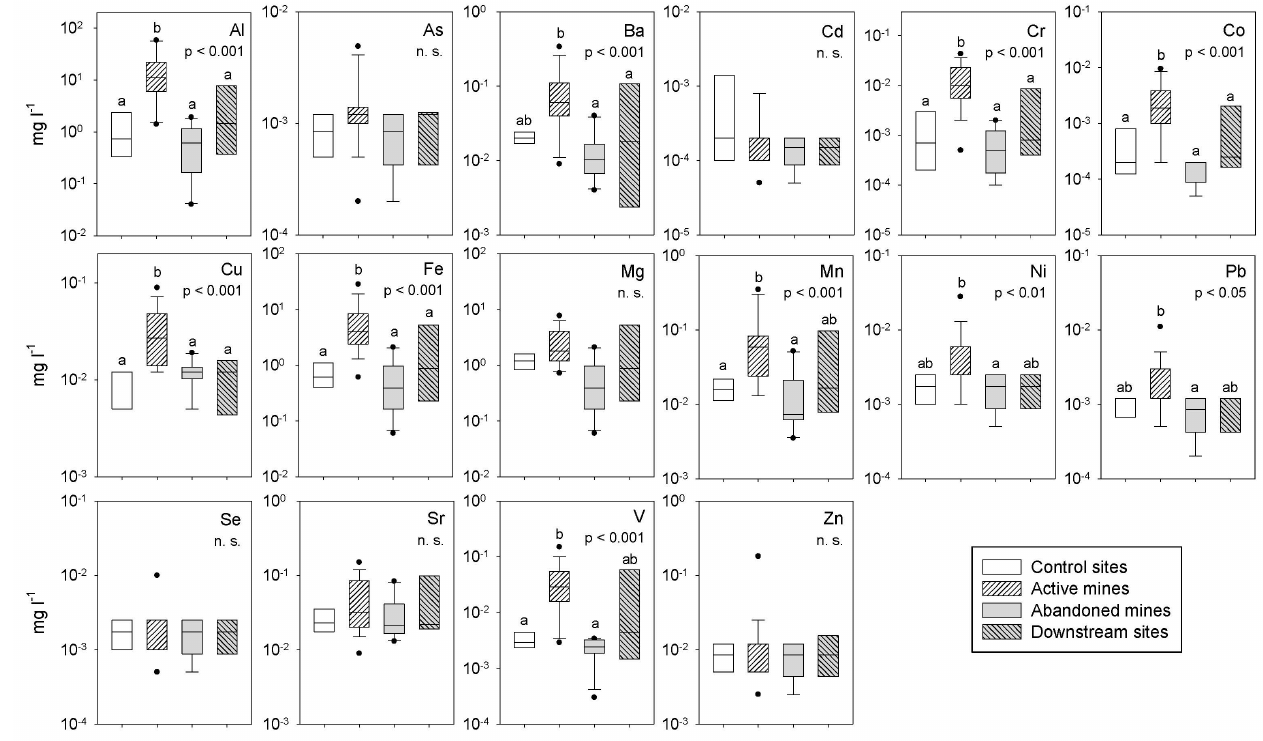
Figure 3. Boxplots of heavy metal concentrations at the study sites. Results of one-factor ANOVAs (location) and multiple comparisons with Tukey are also shown. There are no significant differ- ences among locations with the same letter. Mean values and statistical analyses are detailed in Tables A1 and